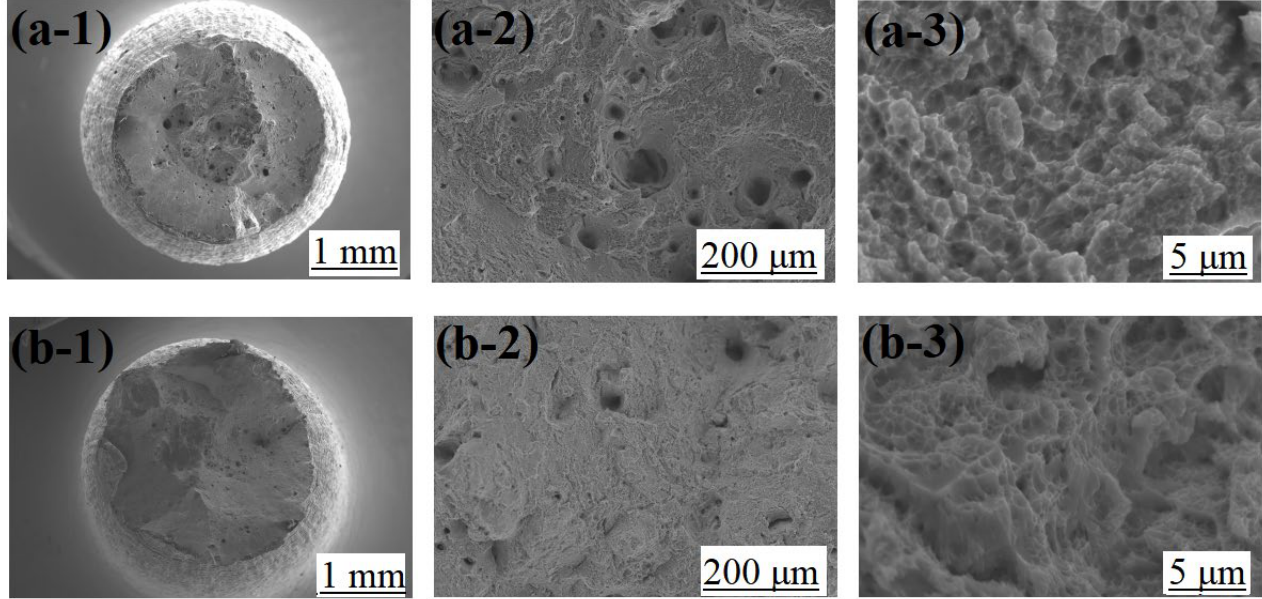
Figure 10. Fracture morphologies of the samples: ( a-1 ) macroscopic fracture morphology of the Z-sample, ( a-2 ) large dimples and holes of the Z-sample, ( a-3 ) small dimples of the Z-sample; ( b-1 ) macroscopic fracture morphology of the XY-sample, ( b-2 ) large dimples and holes of the XY-sample, ( b-3 ) small dimples of the XY-sample.